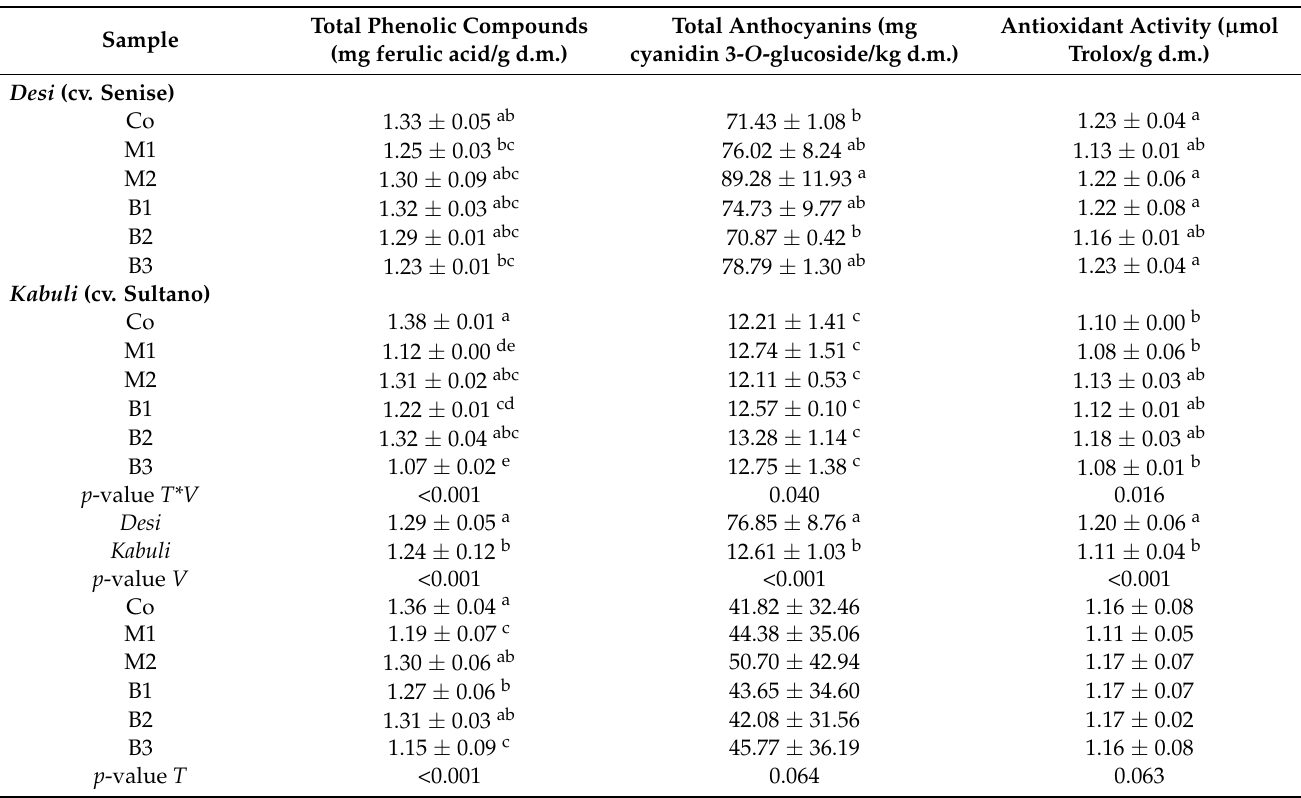
Table 4. The effect of different doses of mineral and organic fertilization on the total phenolic compounds, total anthocyanin compounds, and antioxidant activity of desi (cv. Senise) and kabuli (cv. Sultano) chickpeas (mean ± standard deviation). Total Phenolic Compounds Total Anthocyanins (mg Antioxidant Activity ( µ mol Sample (mg ferulic acid/g d.m.) cyanidin 3- O -glucoside/kg d.m.) Trolox/g d.m.) Desi (cv.